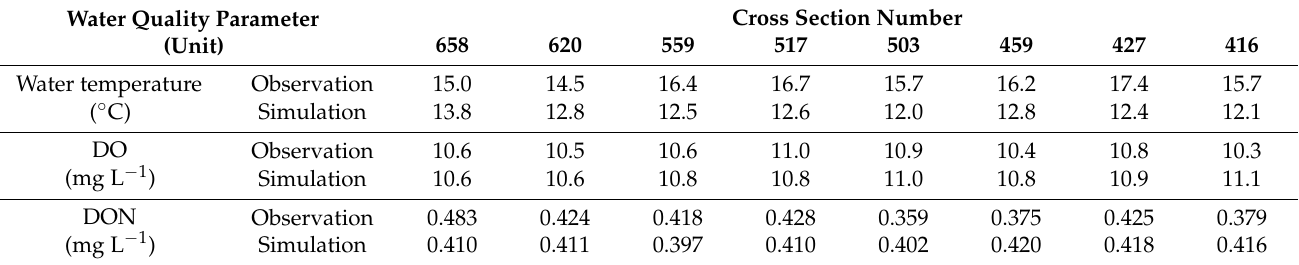
Table 8. Mean values of both the observational data and the simulation results for the water quality parameters from 2019 (calibration) to 2020